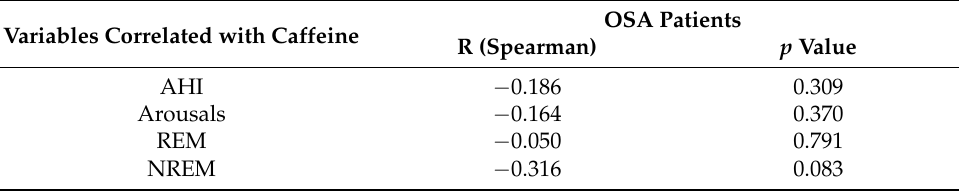
Table 3. Correlation of caffeine concentration in OSA patients with sleep-related parameters: apnea- hypopnea index (AHI), arousals, rapid-eye movement (REM) and non-rapid eye movement (NREM).